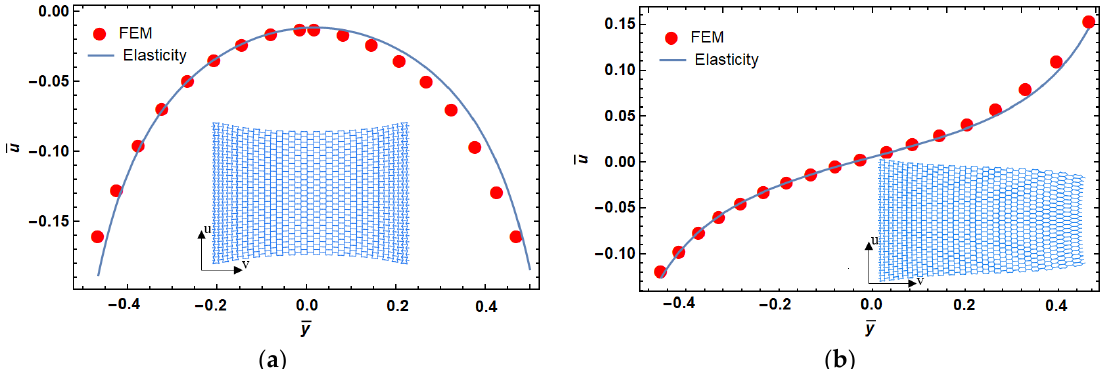
Figure 5. Dimensionless displacement in functionally graded re-entrant structure for the desired parabola ( a ) and cubic ( b ) shapes.